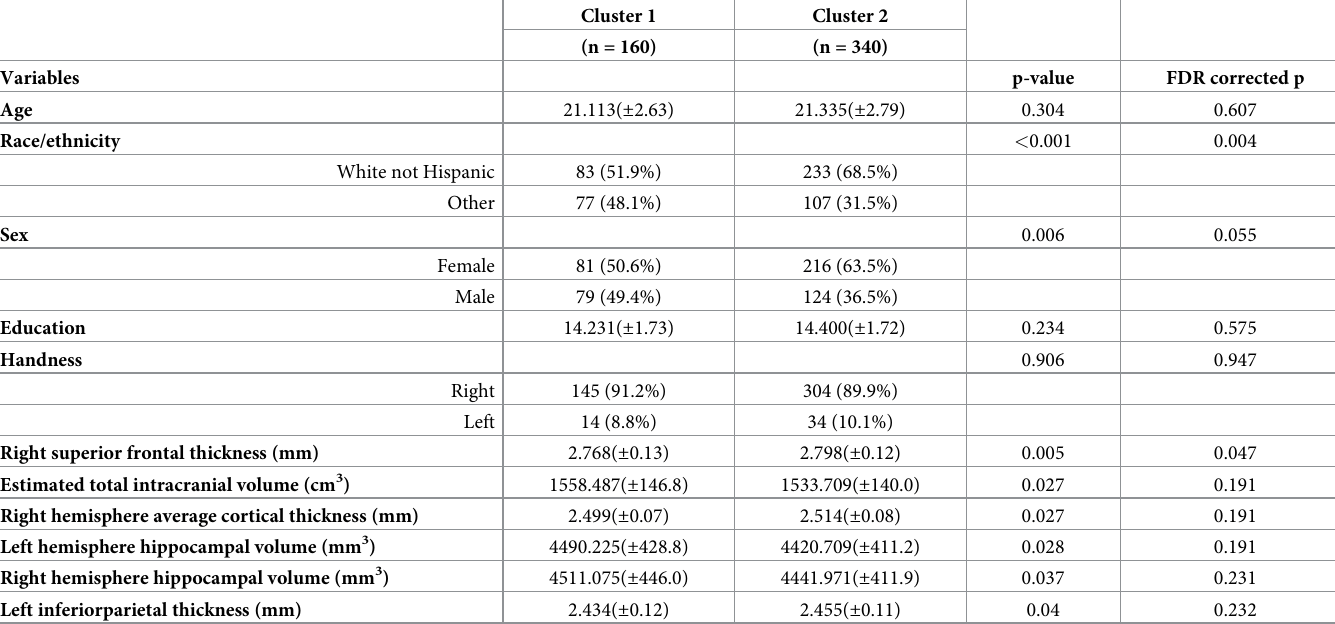
Table 2. Anatomical and demographic variables of interest describing GSP participants but not used for